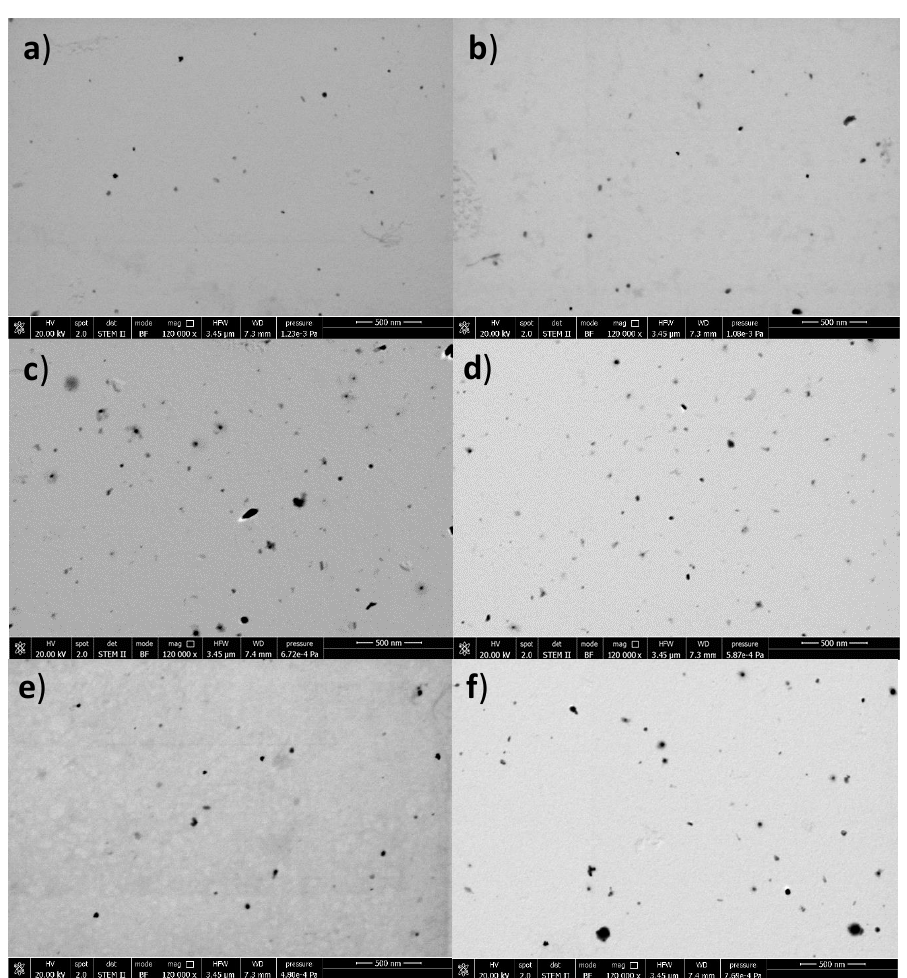
Figure 1. Scanning transmission electron microscopy (STEM) photos of poly(lactic- co -glycolic acid) (PLGA) nanoparticles (NPs) ( a , b ), quaternary ammonium chitosan (QA-Ch) NPs ( c , d ) and quaternary ammonium S-protected thiolated chitosan (QA-Ch-S-pro) NPs ( e , f ) obtained using a field-emission scanning electron microscope with a resolution of 120,000 × and a scale bar of 500 nm. Photos ( a , c , e ) on the left represent the morphological analysis of empty NPs; photos ( b , d , f ) on the right represent the respective cheery extract (CE)-loaded NPs. Table 2. Mass fraction adsorbed onto rat intestinal mucosa from solutions of chitosan derivative (QA-Ch or QA-Ch-S-pro), or dispersions of PLGA NPs, QA-Ch NPs, or QA-Ch-S-pro NPs. PLGA adsorption was not determined because of its insolubility in water.